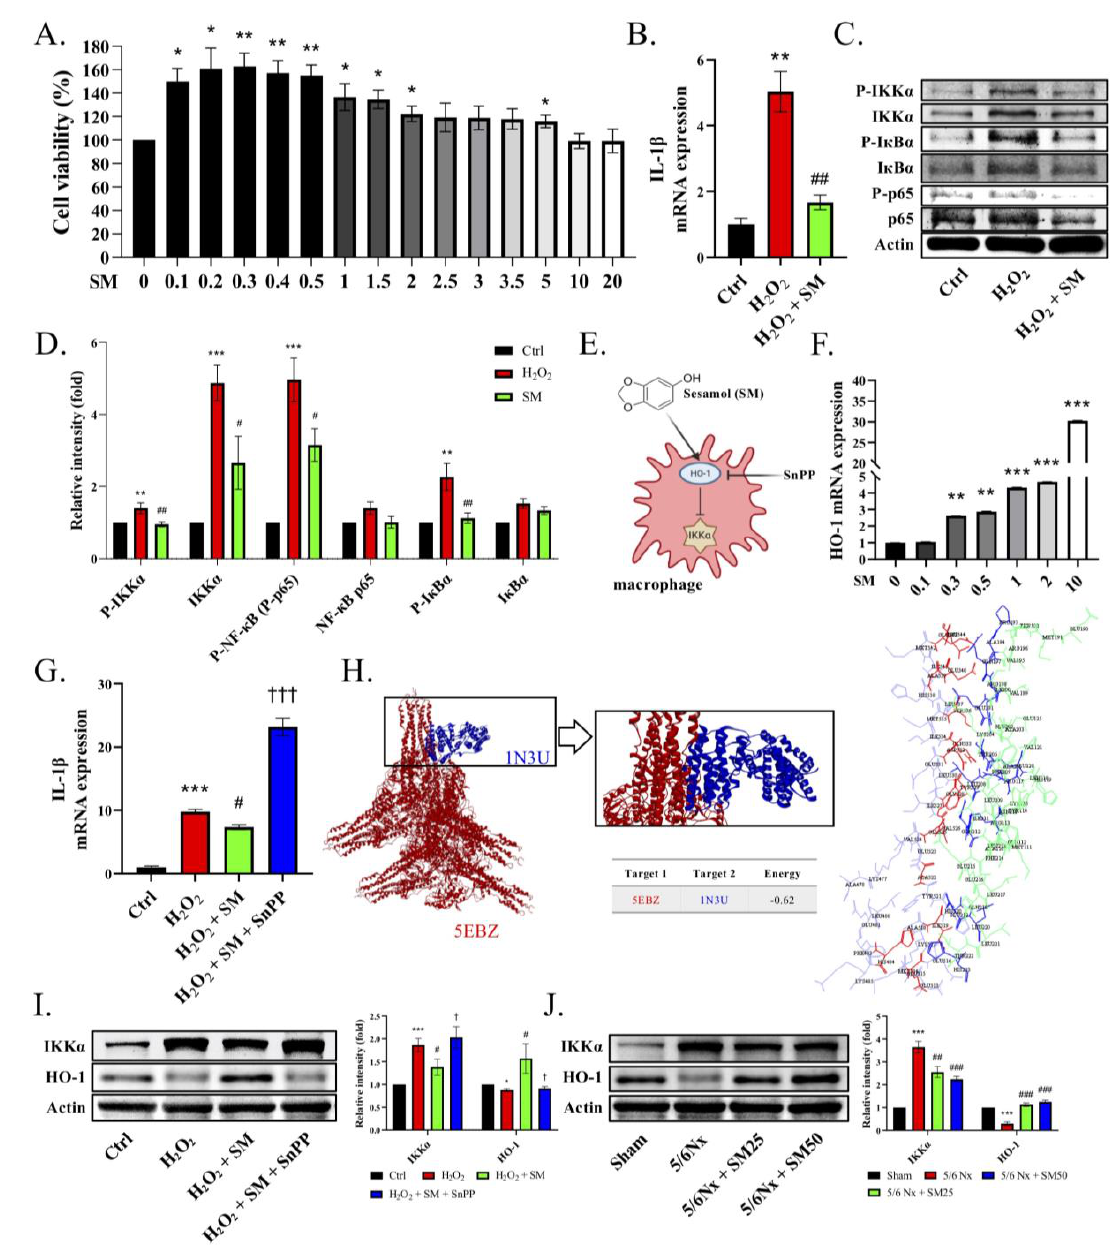
Figure 5. SM inhibits the IKKα signaling pathway via the upregulation of HO-1 in THP-1 cells. The THP-1 cells were differentiated using 25 ng/mL PMA for two days and fresh medium for one day. ( A ) Viability of SM-treated THP-1 cells measured by WST-1 assay. ( B – D ) The THP-1 cells were pretreated with SM or DMSO for 1 h and then stimulated with H 2 O 2 (5 μM) for 24 h. The cells were harvested for qRT-PCR or immunoblotting. ( B ) Transcriptional levels of IL- 1β or ( C , D ) immunoblotting of p- IKKα, IKKα, p -p65, and p- IкBα. ( E ) Expected interactions of SM, heme oxygenase-1 (HO- 1), and IKKα. ( F ) Transcriptional levels of HO-1 after treatment with SM. ( G ) Transcriptional levels of IL- 1β. ( H ) Visualization of the molecular docking pose for the interaction between IKKα and HO -1. Protein –protein interaction between IKKα (PDB code: 5EBZ; red structure) and HO-1 (PDB code: 1N3U; blue structure) in 3D. Protein – protein interaction residue. ( I ) Immunoblotting of IKKα an d HO-1 after the administration of H 2 O 2 , SM, and SnPP to the THP- 1 cells. ( J ) Immunoblotting of IKKα and HO -1 in the kidneys of mice. Data are expressed as the mean ± SEM ( n = 4). * p < 0.05, ** p < 0.01, *** p < 0.001 vs. control, 0 μM group , or sham group. # p < 0.05, ## p < 0.01, ### p < 0.001 vs. H 2 O 2 group or 5/6Nx group. † p < 0.05, ††† p < 0.001 vs. H 2 O 2 + SM group.